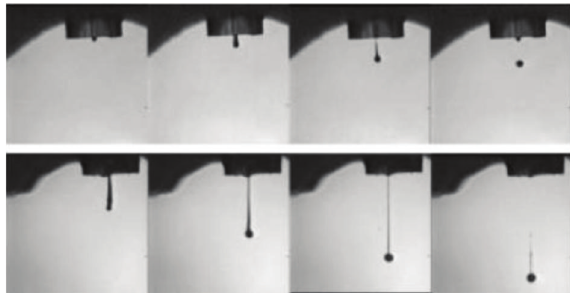
Figure 15: Stroboscopic images of droplets produced by inkjet printing